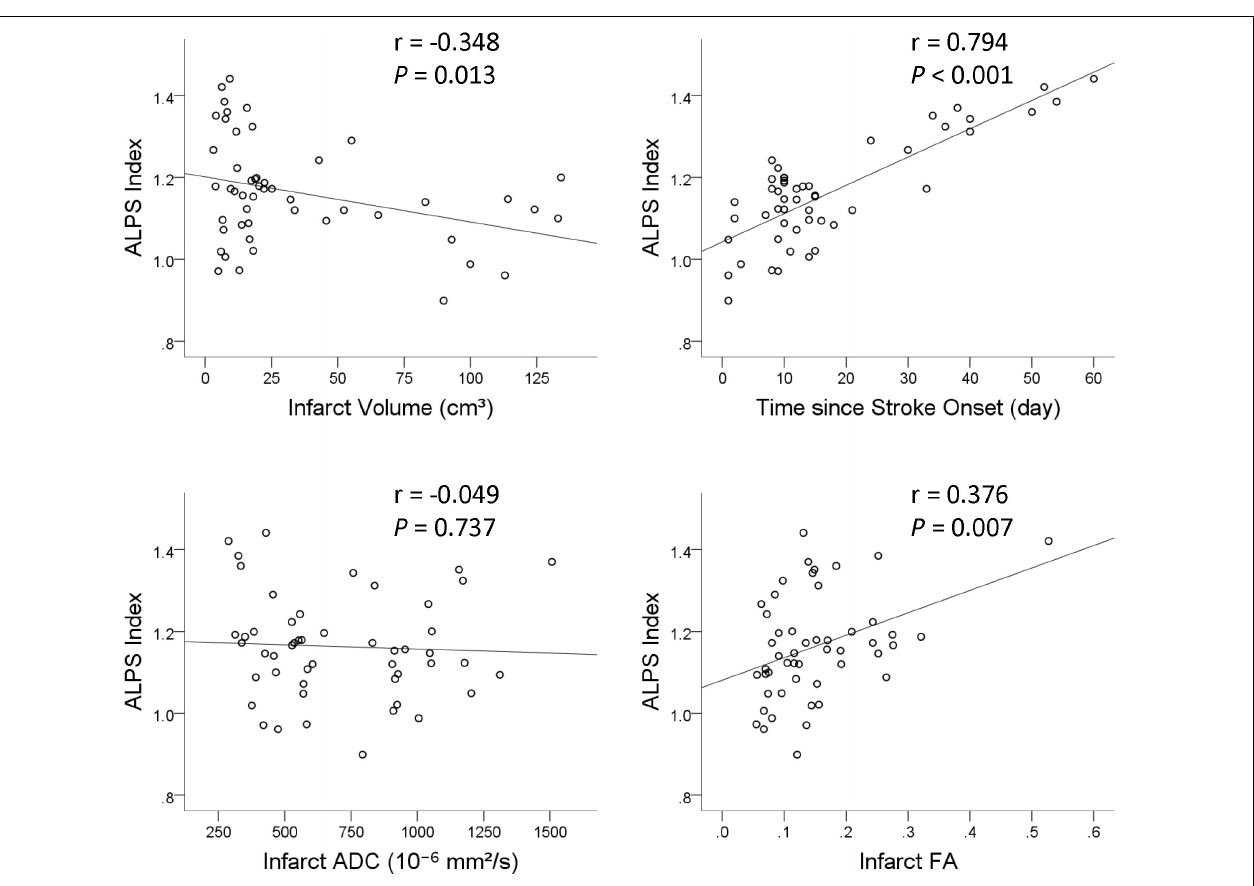
FIGURE 5 | Scatterplots with regression line show the correlations of ALPS index with infarct volume, time since stroke onset, infarct apparent diffusion coefficient (ADC), and infarct fractional anisotropy